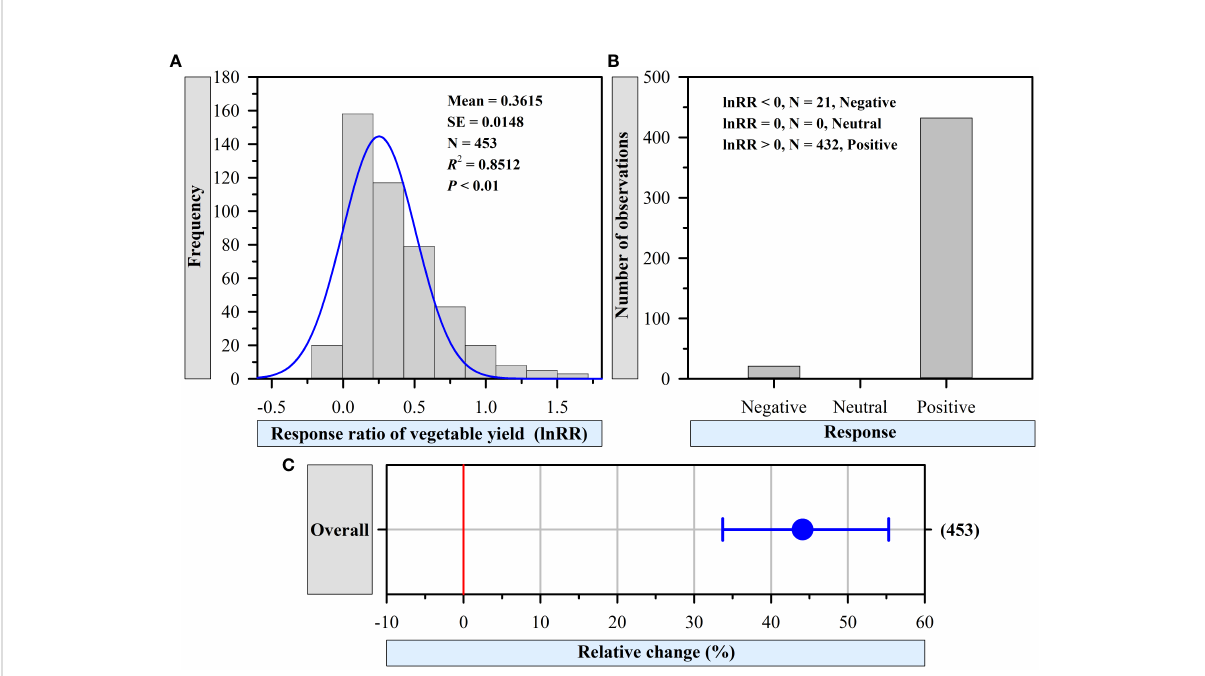
FIGURE 1 Frequency distribution of response ratio (lnRR) (A) , numbers of response (B) , and overall effect (C) of vegetable yield with organic fertilizer compared to that with no fertilizer. The blue fi tted curve is the estimated Gaussian distribution of the frequency, and N represents the number of comparisons. The number of observations is shown right parenthesis. The blue horizontal bar represents the 95% con fi dence interval (CI). The CI does not overlap with 0 red line, which indicates signi fi cant positive effect at P < 0.05.